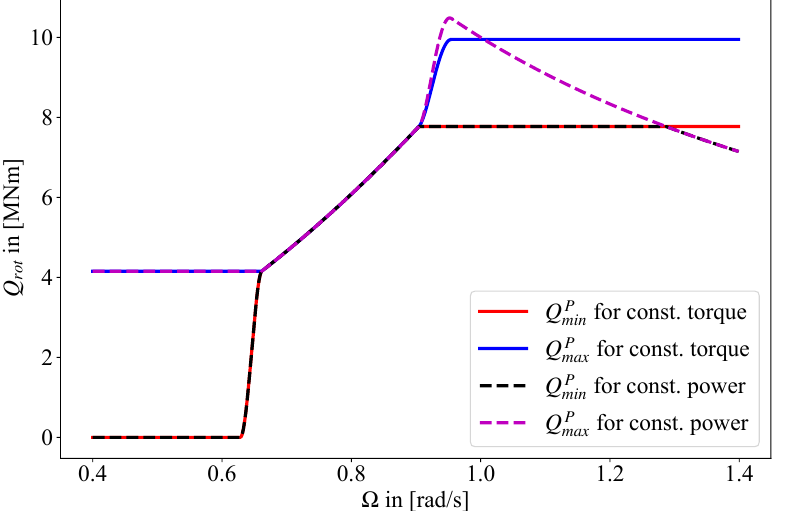
Figure 3. Limits for torque controller at the partial load regime. Limits are shown for the constant power and constant torque